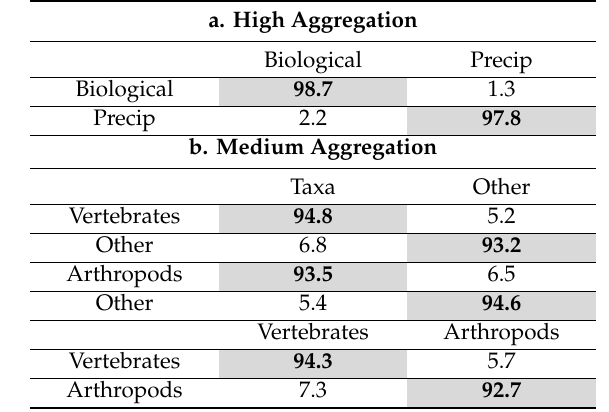
Table 3. Classification results of binary RF models, each focused on a specific scatterer type at high and moderate levels of aggregation. Values are percent of the total out-of-bag samples assigned to that class. “Taxa” below refers to the corresponding focal class, vertebrates or arthropods, in their respective confusion matrices. Percent true positive classifications are highlighted and bold. “Other” is a class of resolution cells equally represented by the non-focal classes, i.e., the non-vertebrate classes and precipitation or the non-arthropod classes and precipitation. Interpretation of confusion matrices can be found in Figure A3.